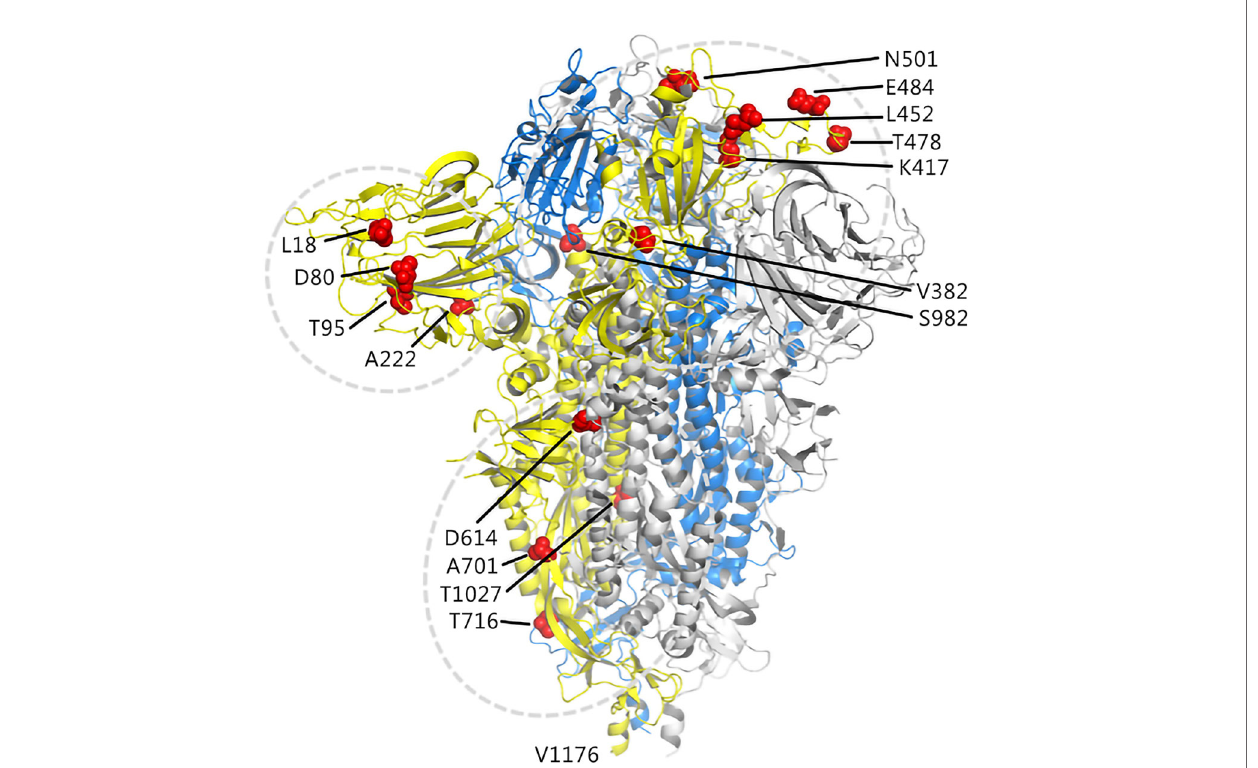
FIGURE 2 | Illustration of candidate sites on the S protein. The three chains of the trimer structure of S protein (PDB 7DF3) are shown in cartoon and represented as yellow, marine, and gray. The mutation sites of interest are shown as red